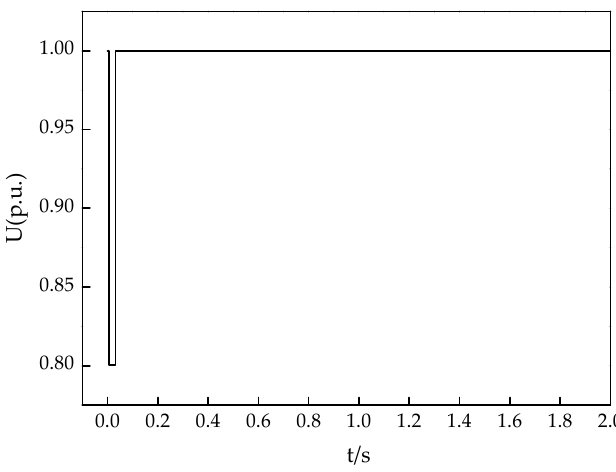
Figure 4. Reference value of the voltage at the point of common coupling (PCC).